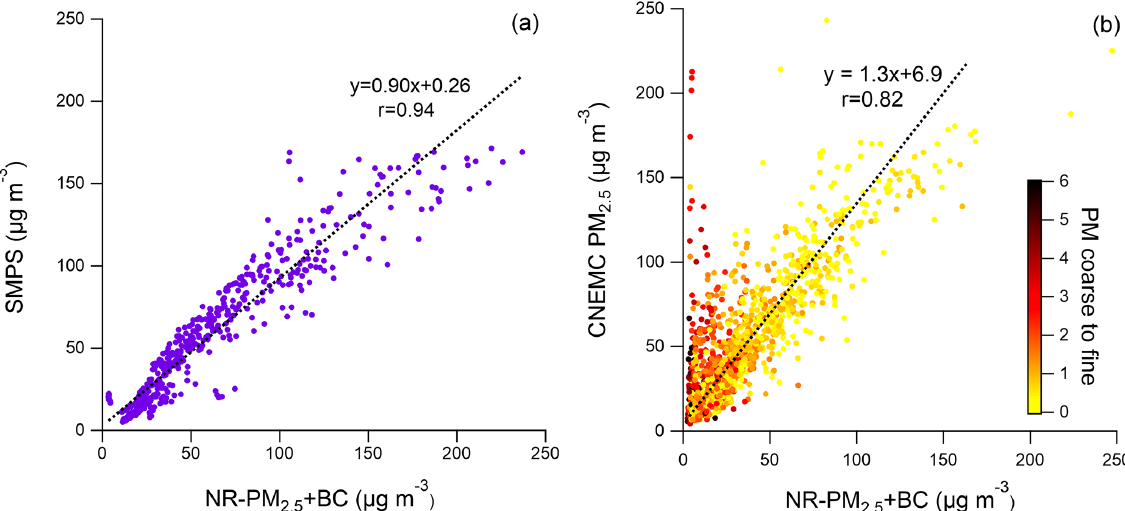
Figure 1. Scatterplot of (a) calculated PM mass concentration of SMPS and measured NR-PM 2 . 5 + BC. (b) Comparison between CNEMC PM 2 . 5 and NR-PM 2 . 5 + BC during the sampling period. PM coarse to fine is defined as the ratio of (PM 10 − PM 2 . 5 )/ PM 2 . 5 measured at